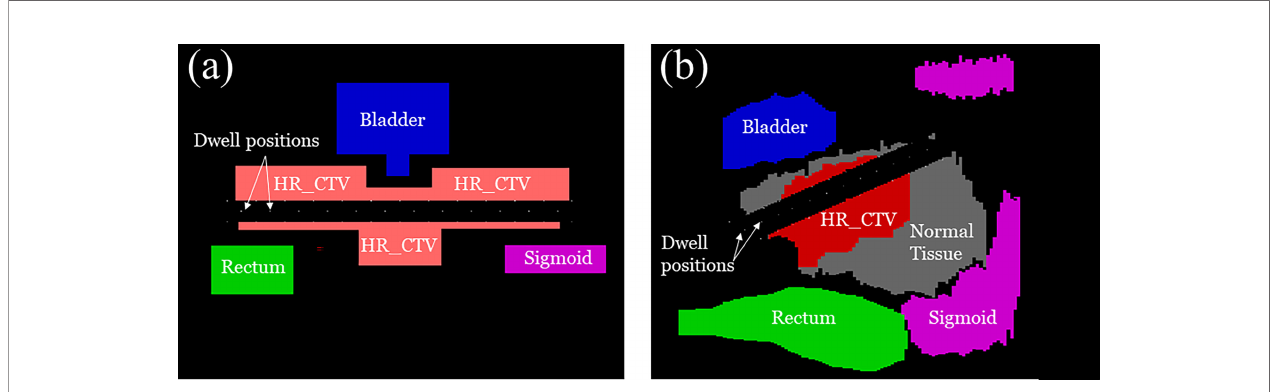
FIGURE 6 | A schematic illustration of (A) 2D phantom and (B) 2D patient models used for the experiment including the clinical tumor volume (CTV) in relation to organ positions of